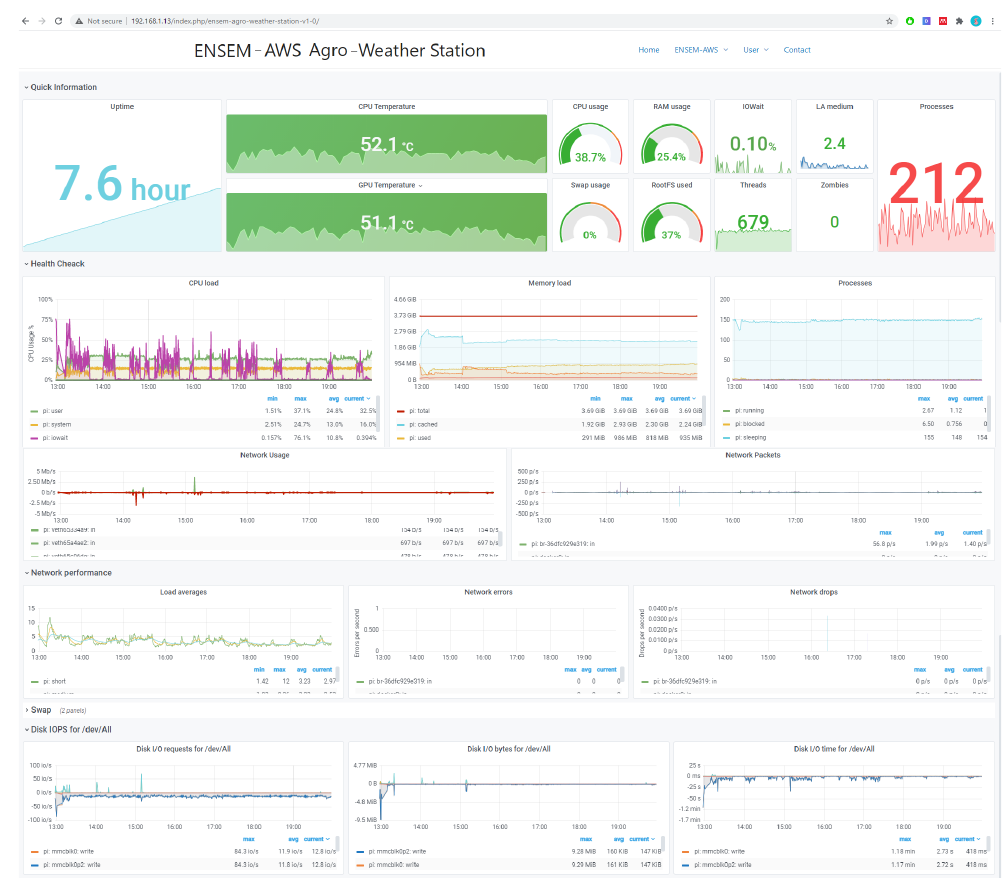
Figure 11. The agro-weather station